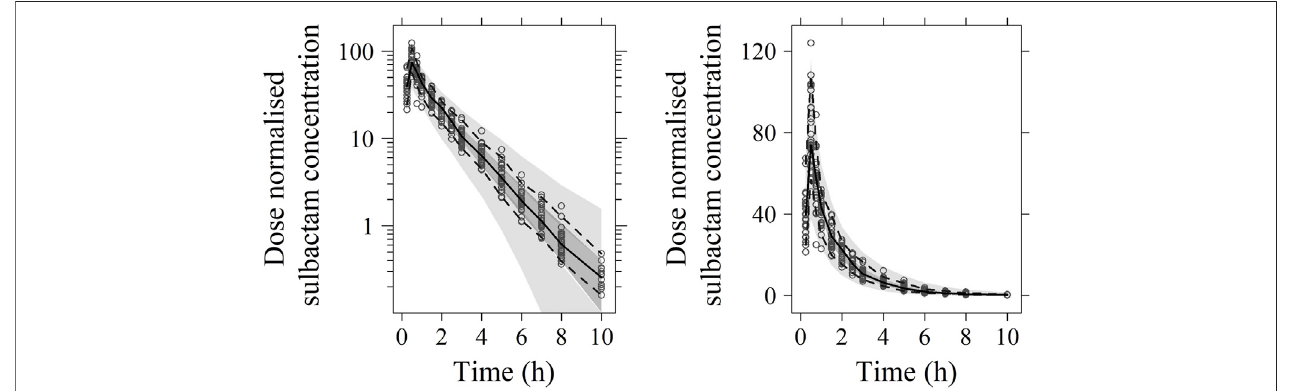
FIGURE 4 | Visual predictive check (VPC) of sulbactam PK model (left: in logarithmic scale; right: in arithmetic scale). The range between the dashed lines depicts the 90th percentile intervals. The solid lines represent the medians of simulated data. Circles represent the observed data.